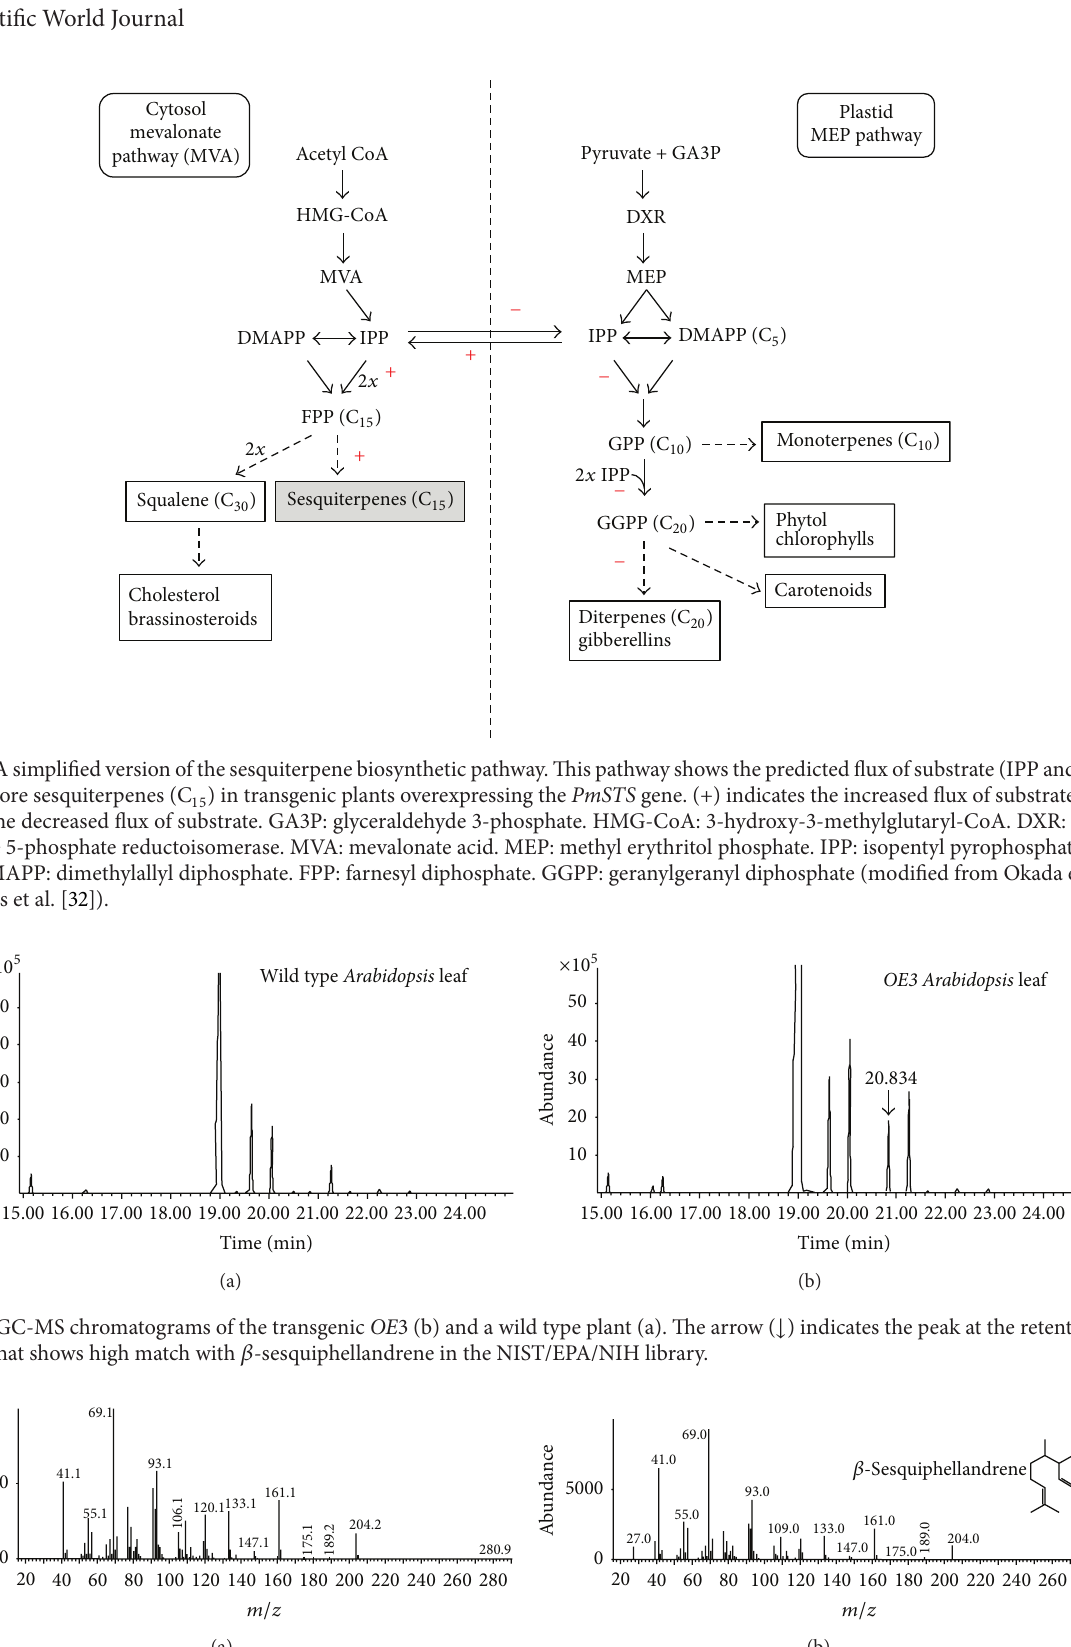
Figure 10: Mass spectra of 𝛽 -sesquiphellandrene. (a) shows the mass spectrum for the sample compound, while (b) shows the mass spectrum of the highest hit in the NIST/EPA/NIH